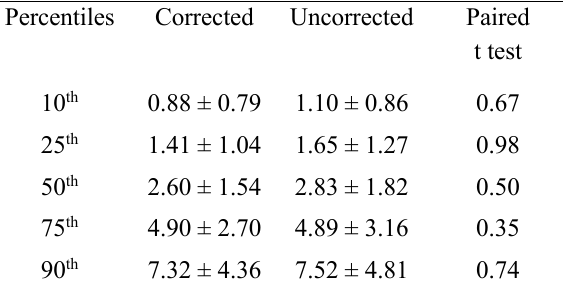
Table 3: Percentile Amplitude of Microsaccade/Saccade elicited in the right eye of subjects in corrected and un- corrected state during viewing of a blank scene.